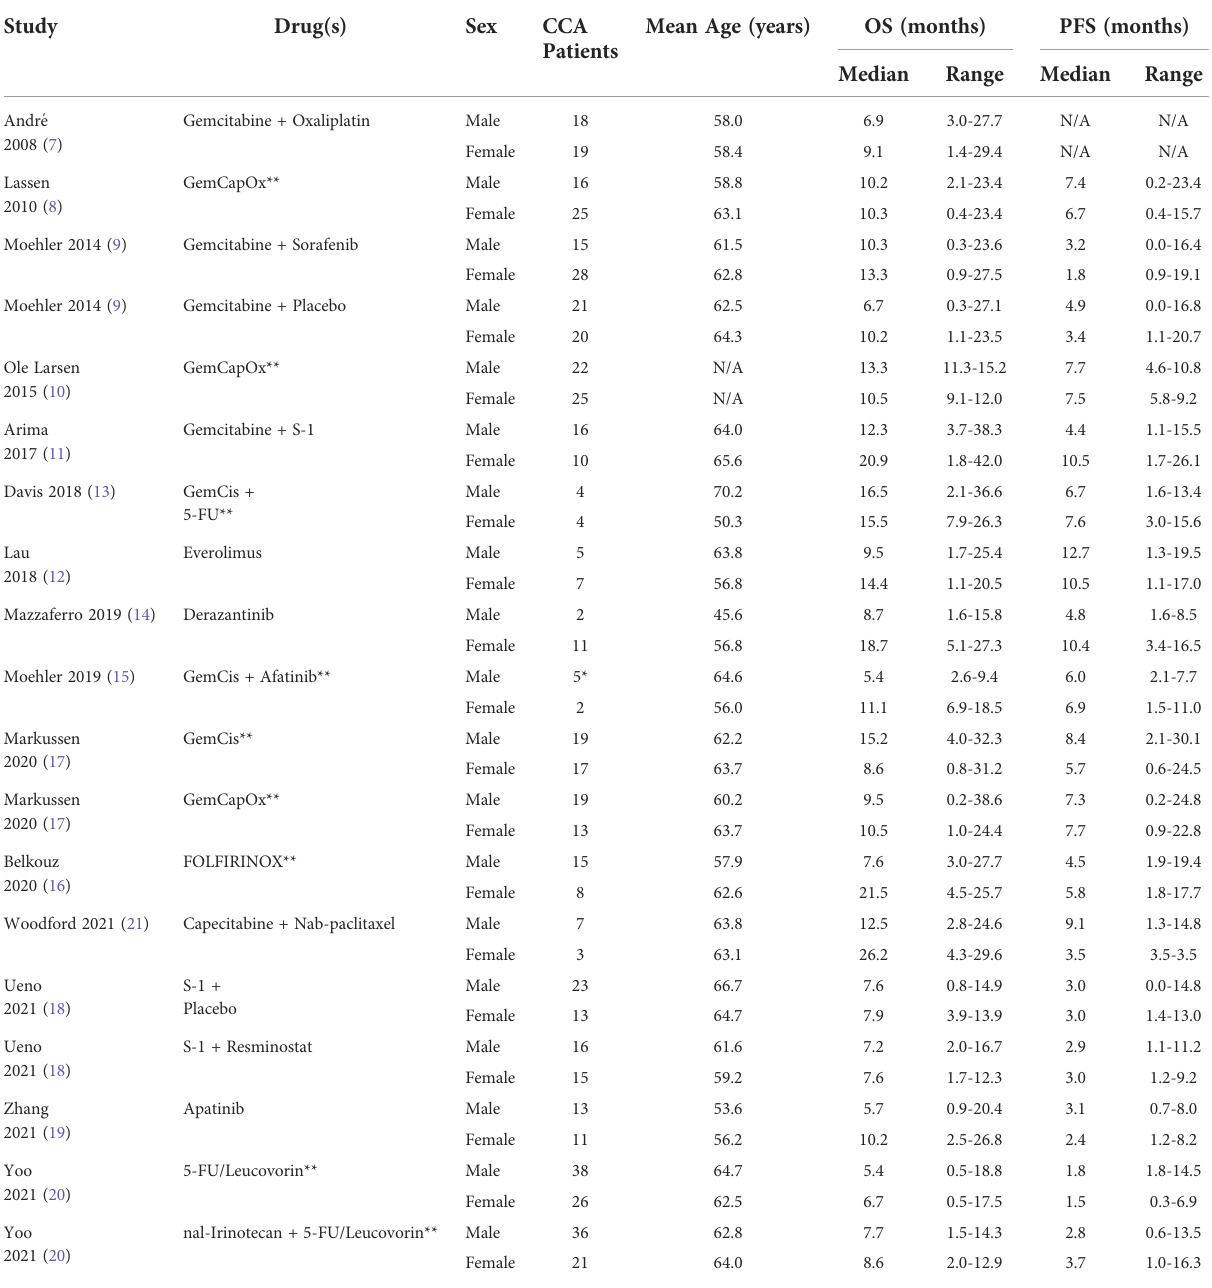
TABLE 2 Survival data of included